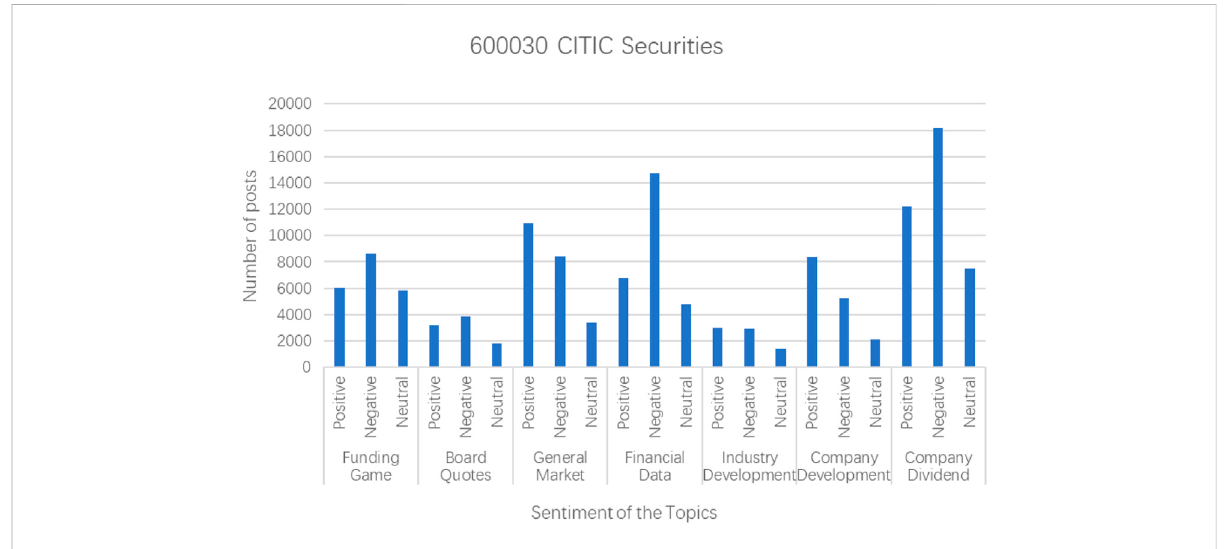
FIGURE 4 Sentiment analysis results of speci fi c stock